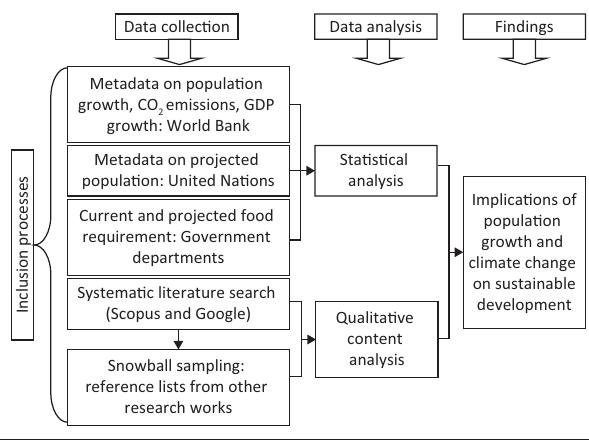
FIGURE 2: Methodological flow chart of this study.